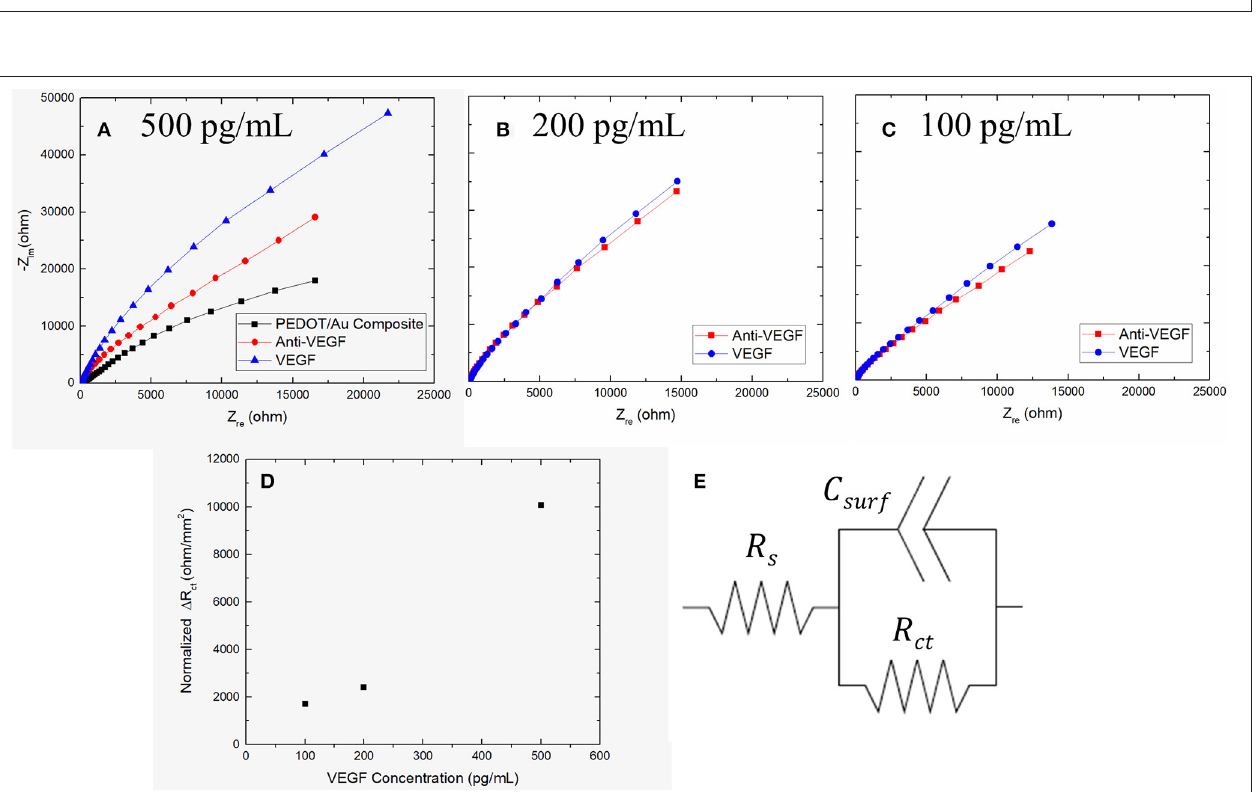
FIGURE 3 | Nyquist plots of impedance spectra obtained from the increasing concentration of VEGF of (A) 500 pg/mL (B) 200 pg/mL (C) 100 pg/mL on three stainless steel electrodes and (D) Plot of 1 R ct as a function of VEGF concentration (E) Schematic diagram of an equivalent circuit model.